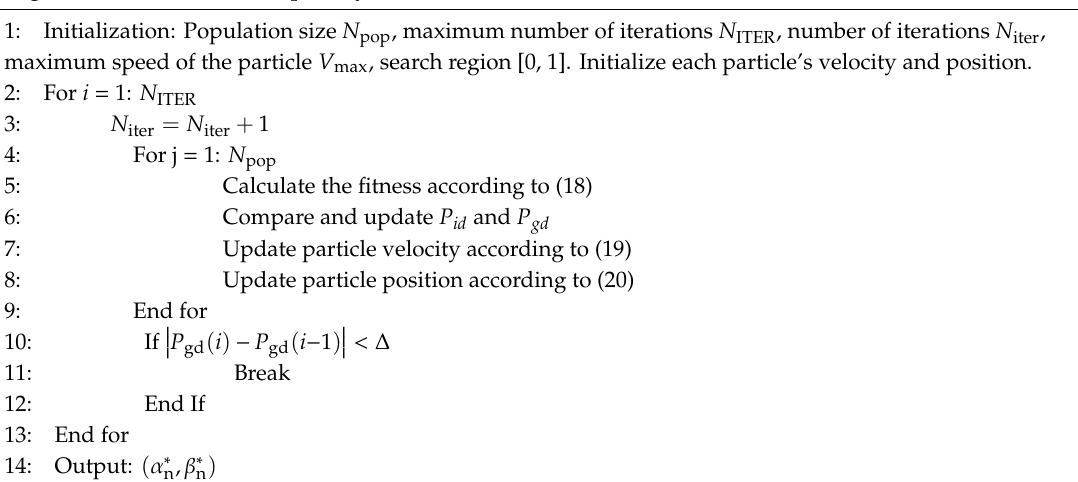
Algorithm 1. PSO based on penalty